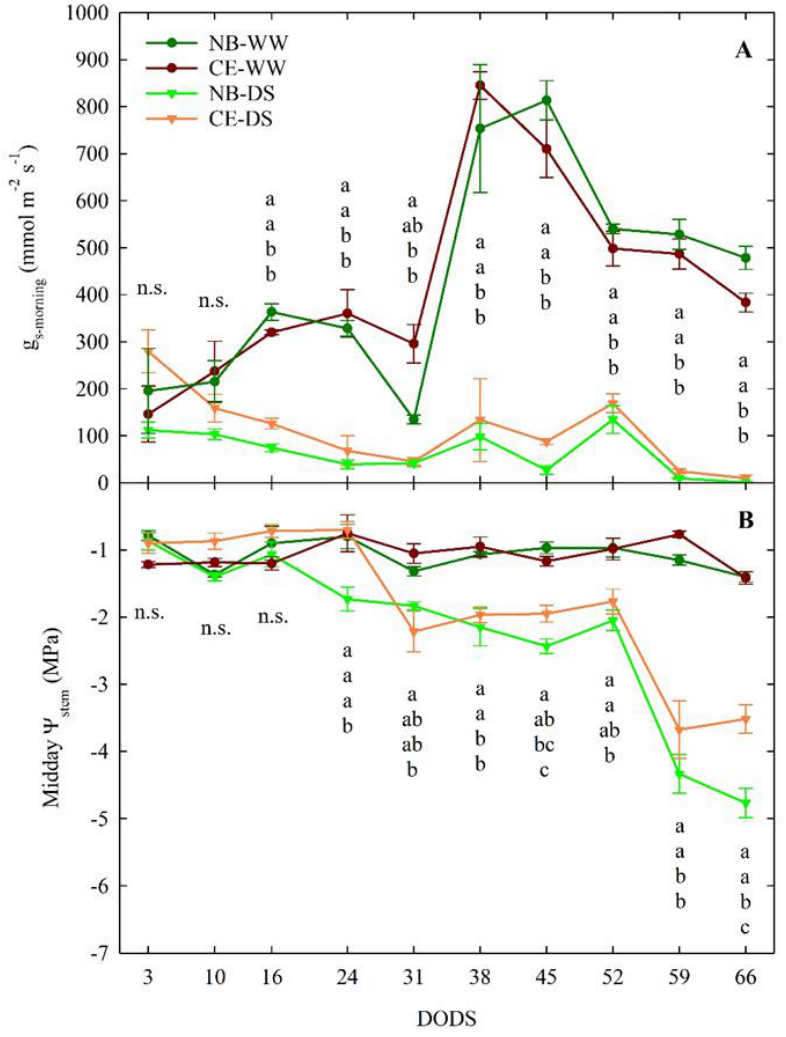
Figure 2. Mid − morning (1000 h) leaf stomatal conductance (g s-morning , ( A )) and midday stem water potential ( Ψ stem , ( B )) of well-watered and drought-stressed ‘Nocellara del Belice’ (NB-WW and NB-DS, respectively) and ‘Cerasuola’ (CE-WW and CE-DS, respectively) olive trees. Error bars indicate the standard errors of the means. For each day of drought stress (DODS), different letters indicate significant differences among treatments according to Tukey’s test following analysis of variance ( p < 0.05).